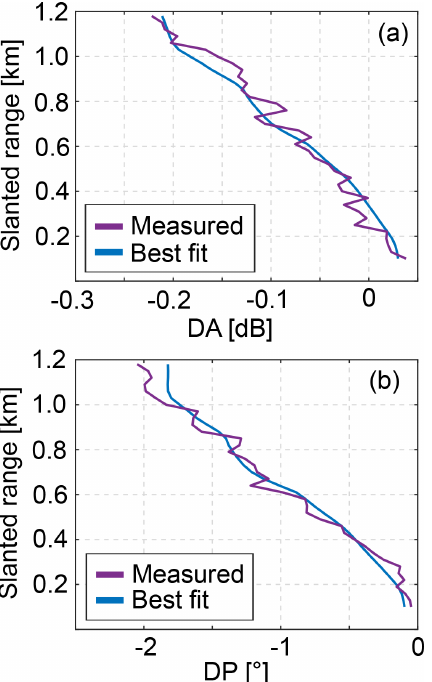
Figure 13. Range profiles of DA (a) and DP (b) . Blue solid lines correspond to the best fit found by the self-consistency method for radar 1, with C Z = − 0 . 7dB. The magenta lines represent profiles estimated from the measurements (shown by blue lines in Fig. 12). The results are obtained for the cases shown in Figs. 10 and 12.